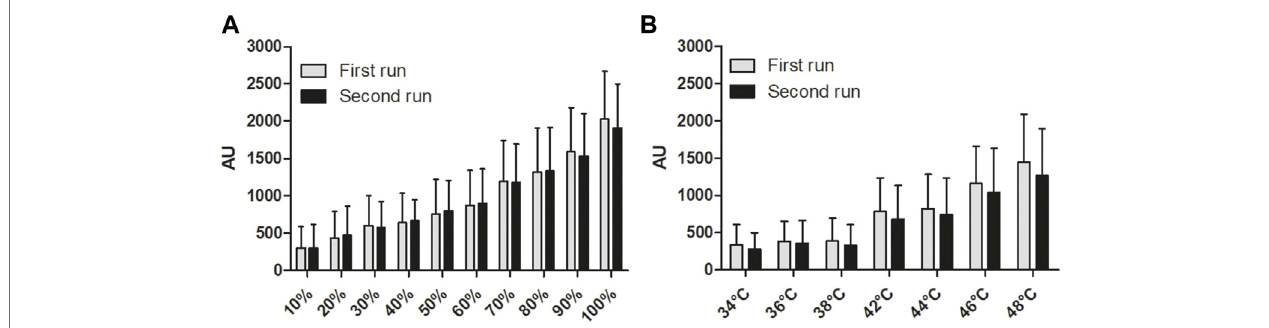
FIGURE 3 | Test-retest results of the eEgg. Handgrip strength values from the eEgg (AU) according to (A) different intensities and (B) different temperatures of the fi rst and second run, respectively. Data are presented as mean values ± standard deviation. eEgg, electronic egg.